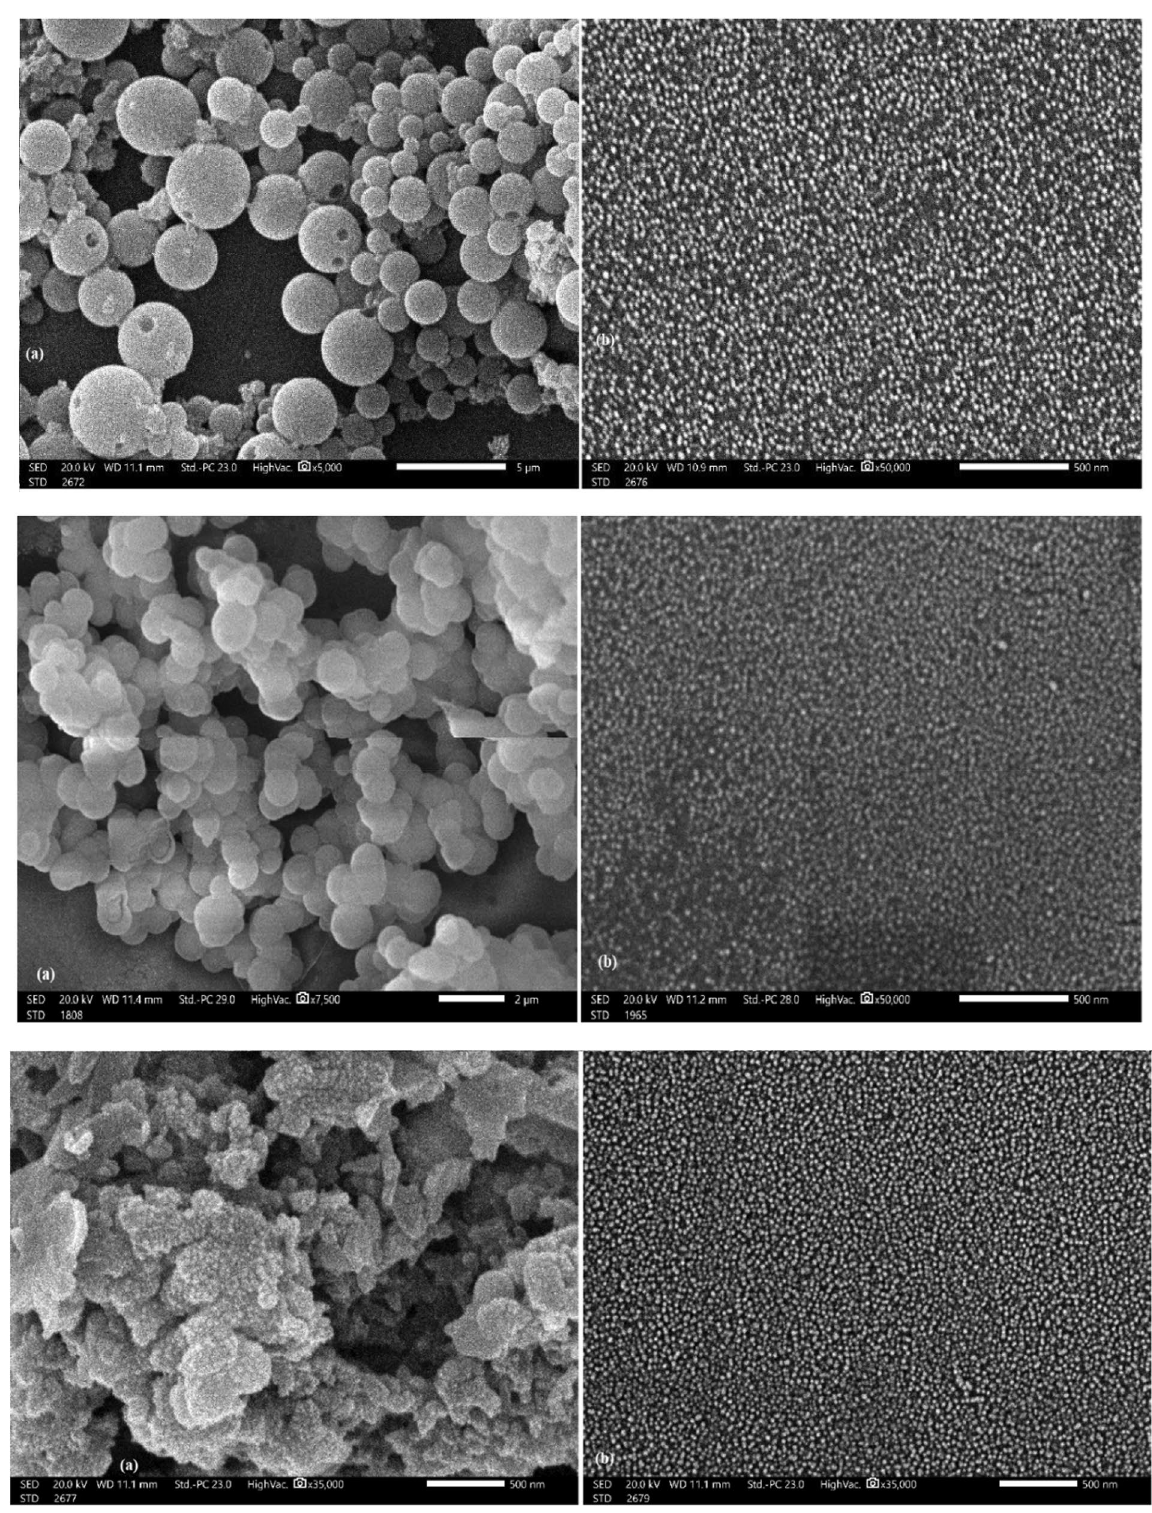
Fig. 3 SEM images of: (upper) Copolymer 6 [scale bar ( a ) 5 μm; b ) 500 nm]; (middle) The composite SiO 2 @Ag 3 [scale bar ( a ) 2 μm; b ) 500 nm]; and (bottom) the copolymer/L-ascorbic/SiO 2 @Ag composite 7 : ( a ) solid state; ( b ) suspension in